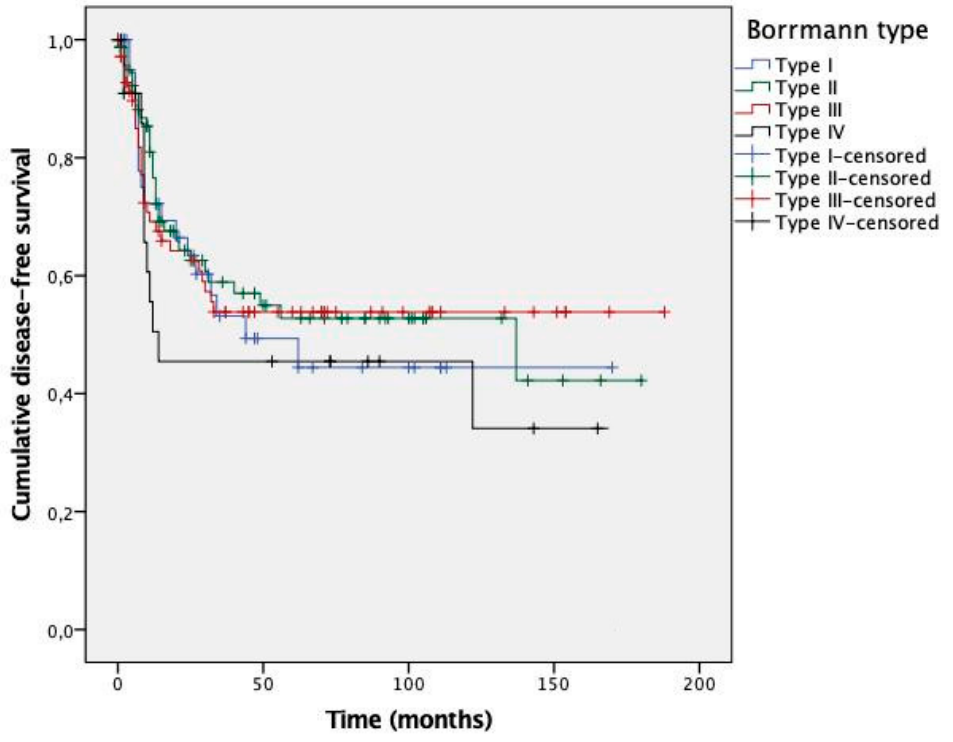
Figure 2. Kaplan–Meier curves for disease-free survival according to Borrmann type. The p -value by log-rank test was 0.607. Table 6. Mean disease-free and overall survival times according to Borrmann